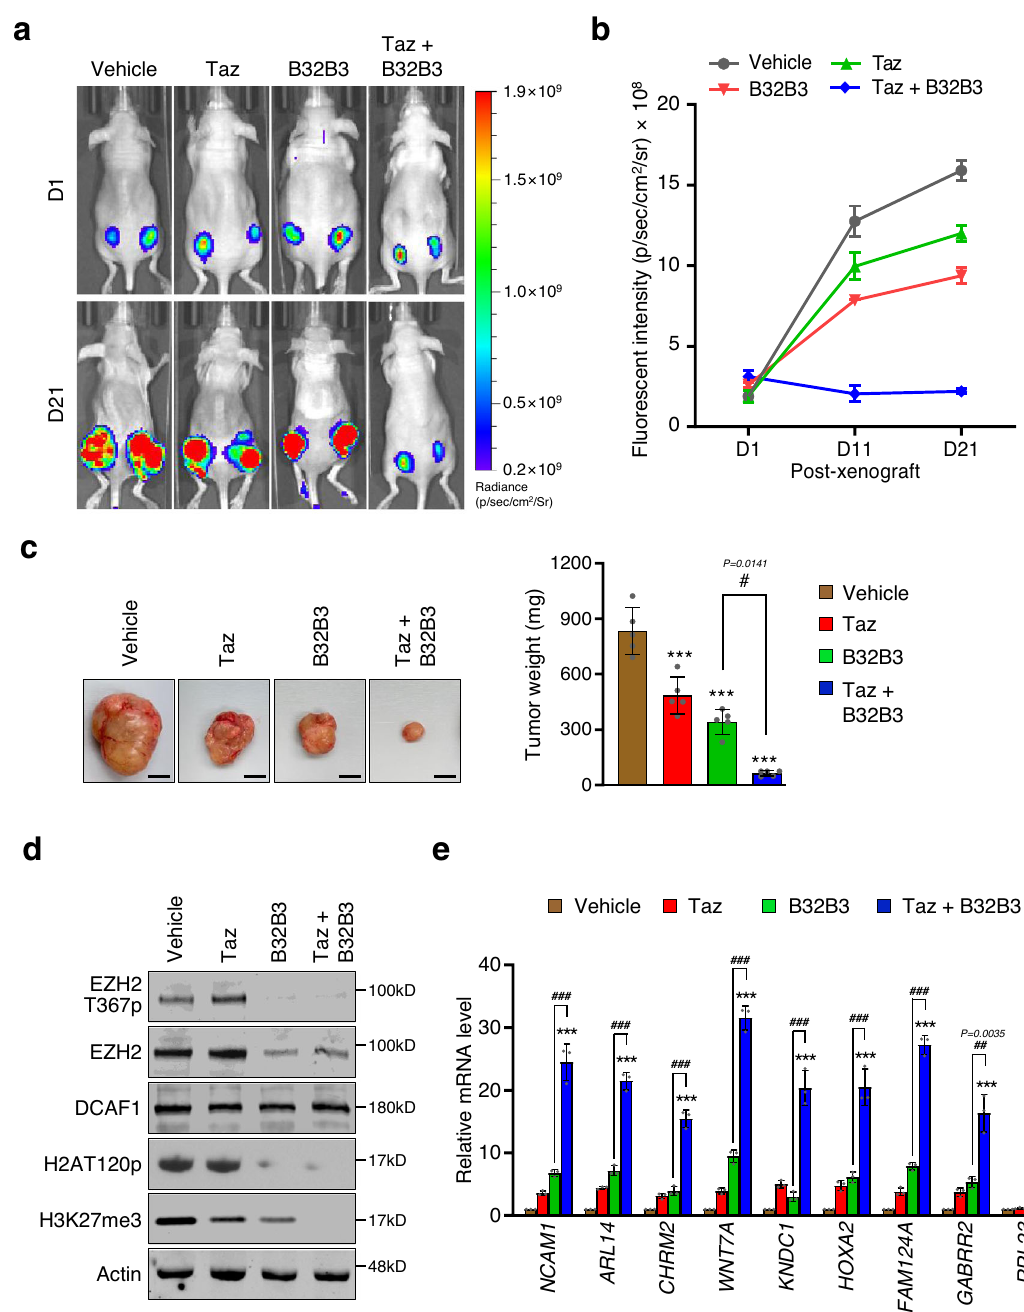
Fig.7|ImpairedtumorgrowthinmicetreatedwithDCAF1andEZH2inhibitors. a SW620coloncancercellswerestablytransfectedwithEGFPexpressionconstruct and subcutaneously injected into both right and left hind legs of mice. After initial tumor growth for 4 days, mice were randomized into four cohorts and treated for 21 days with intraperitoneal injection of vehicle daily, oral administration of Taz (200mg/kg) twice daily, intraperitoneal injection of B32B3 (5mg/kg) every three days or Taz administration plus B32B3 injection. Tumor growth was monitored by checking fl uorescent signals detected at wavelengths of 581nm with an in vivo imagingsystem(IVIS)after1,11and21daysoftreatments.(SeealsoSupplementary Fig. 18). b Fluorescence intensities were quanti fi ed using regions of interest (ROIs) of equivalent-sized areas from lower abdominal regions at the indicated time points. Data are presented asmean±SEM ( n =8). c Mice were sacri fi cedatthe end of 21-day treatments with Taz and/or B32B3, and subcutaneous tumors were sur- gically excised and photographed (left panel, scale-1cm). The weight of tumor